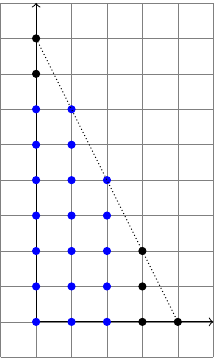
Figure 3. The Newton polygon for the ( A N − 1 , A k − 1 ) theory, drawn for N = 4 and k = 2 N = 8 . The black points represent excluded deformations corresponding to the x N − 1 and z k − 1 lines, as well as the bounding points x N and z k . The blue points that lie on the dotted line bounding the triangle correspond to the N − 2 exactly marginal